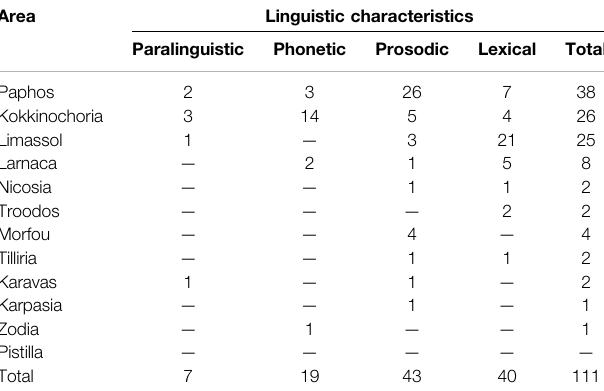
TABLE 3 | Linguistic characteristics. Area